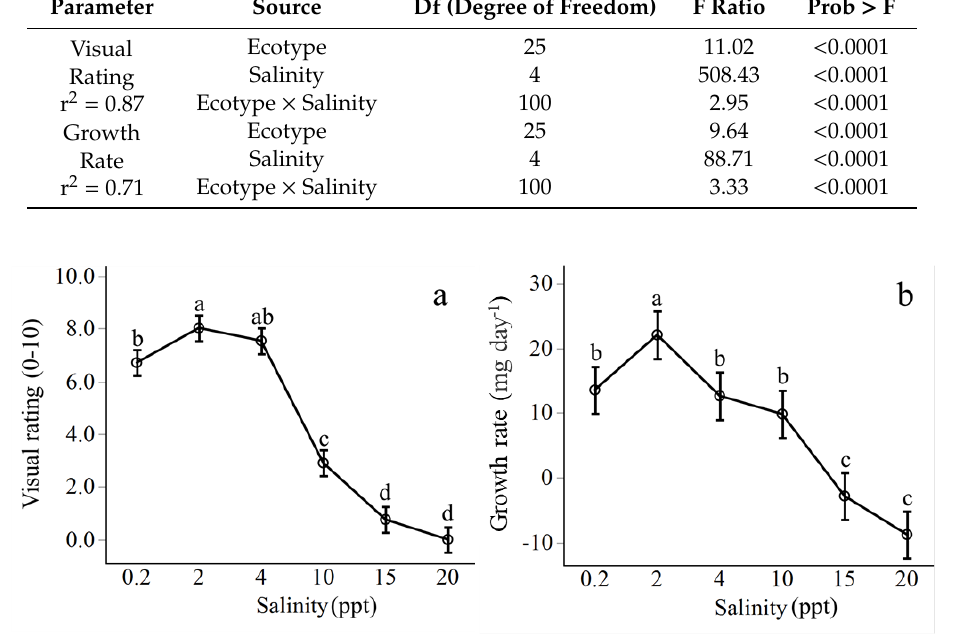
Figure 2. Visual rating ( a ) and growth rate ( b ) of Vallisneria americana ecotypes. Each circle and error bar represent 96 observations. Letter differences on top of the bars denote significant ( p < 0.05 ) differences among ecotypes.